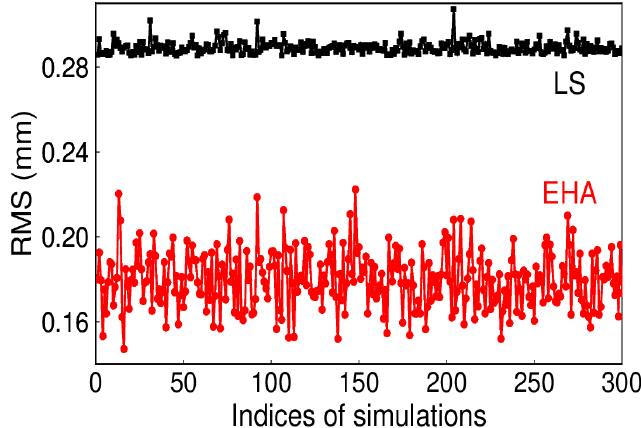
Figure 17. RMS for the signal extracted (by EHA and LS) and the simulated.